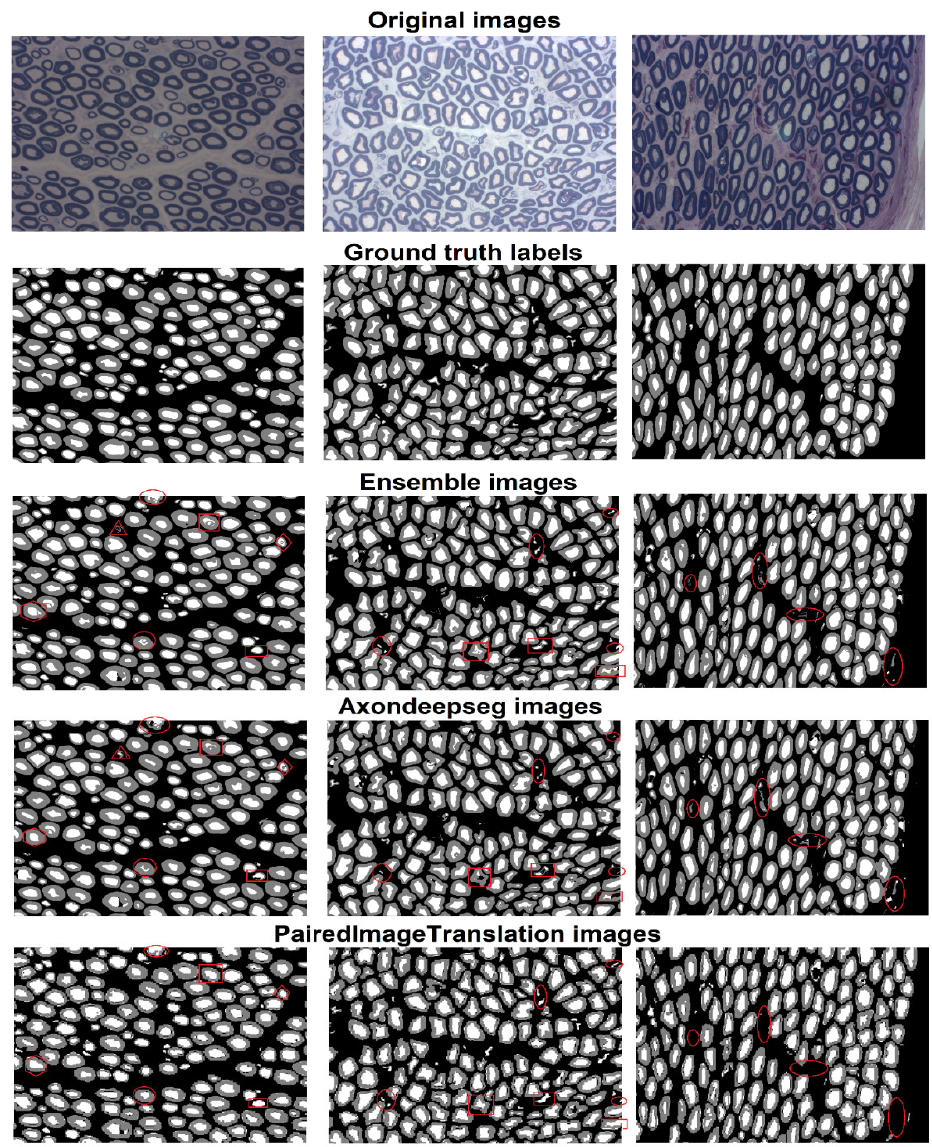
Figure 5. Qualitative representation of the segmentation results of three testing whole images using the ADS, PIT, and ensemble models. the ADS, PIT, and ensemble